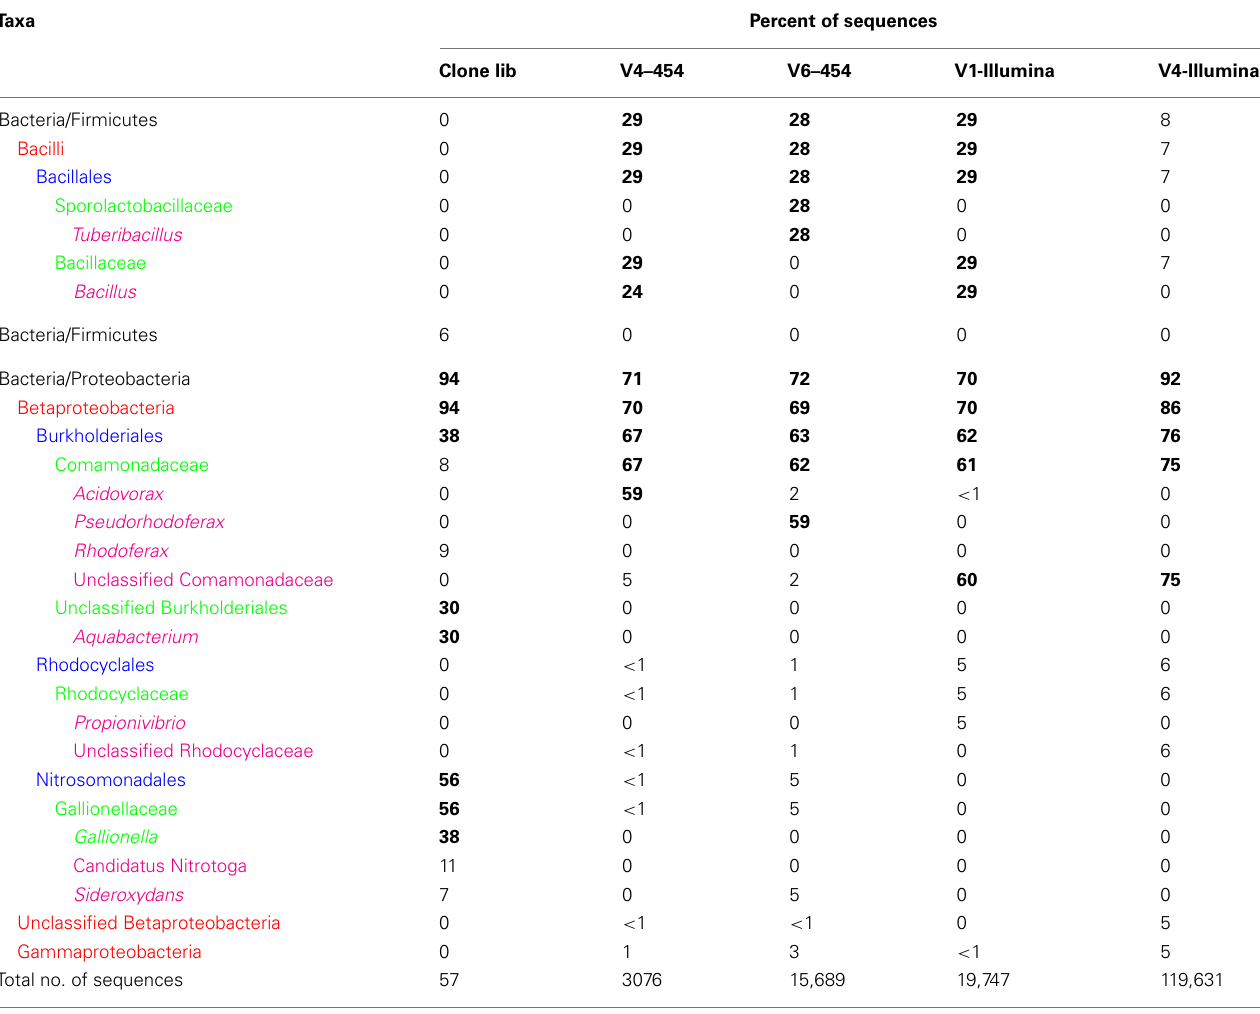
Table 4 | Relative abundance (percentage of total sequences) of different phylogenetic taxa obtained conventional cloning and sequencing (Clone lib) and by pyrosequencing of 16S rRNA genes from site 2 (microbial mat) using different sequencing platforms and primer